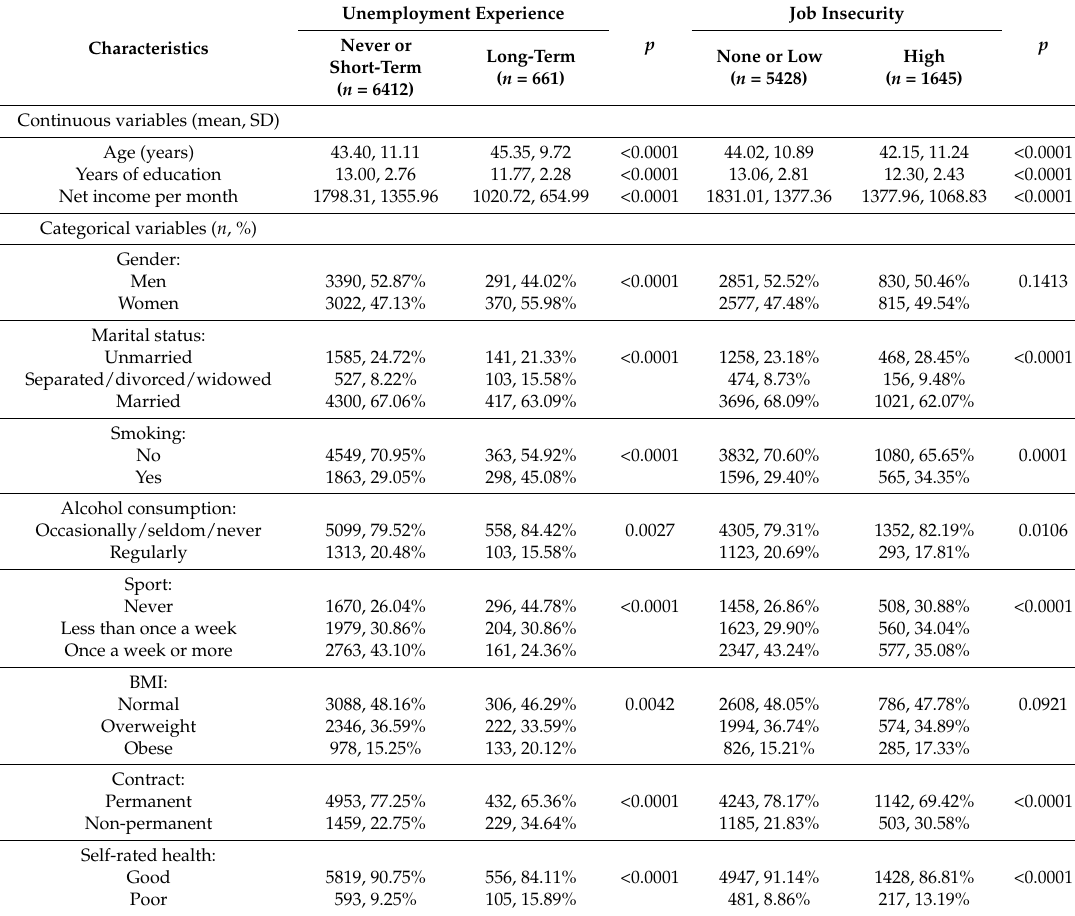
Table 1. Characteristics of study sample at baseline ( n =